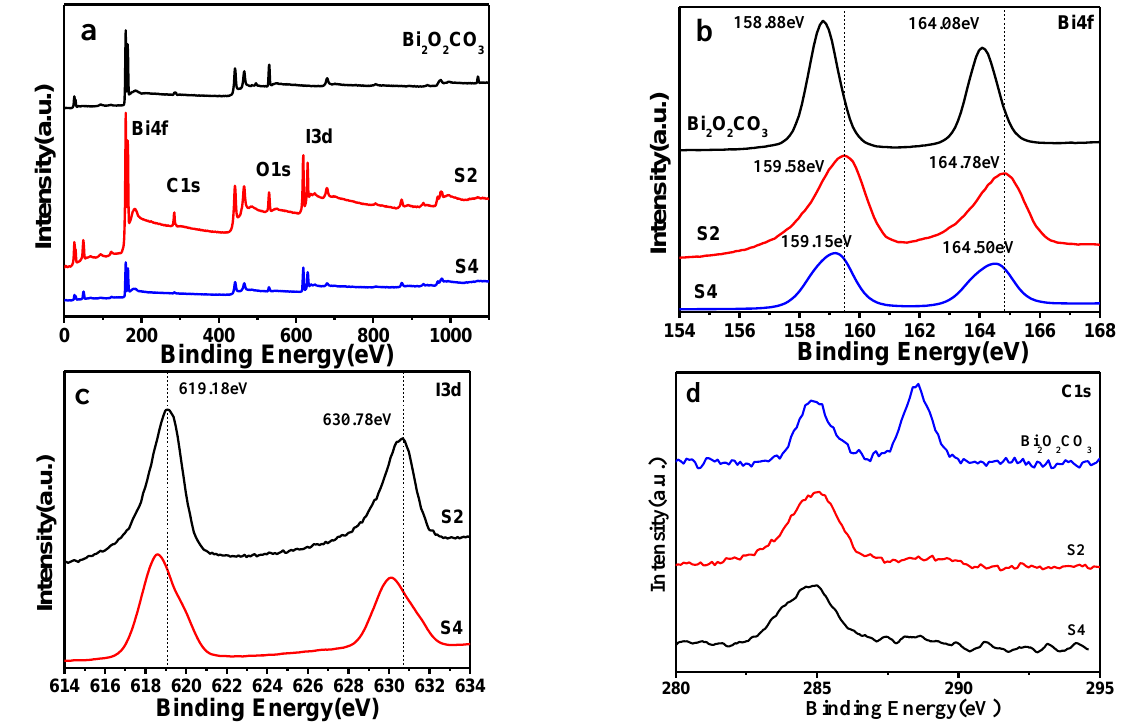
Figure 3. Survey ( a ) and high-resolution Bi 4f ( b ), I 3d( c ), and C 1s ( d ) XPS spectra of Bi 2 O 2 CO 3 , S2 and S4 samples. The FTIR spectra of Bi 2 O 2 CO 3 , S2 and S4 samples were measured, as shown in Figure 4. The intensive peak which centered at 847.1 cm − 1 is attributed to the ν 2 modes of the CO 32 − group. After Bi 2 O 2 CO 3 and BiOI are combined with each other, a new peak at 493.6 cm − 1 appears in S2 sample, further proving the formation of the strong interfacial junction between Bi 2 O 2 CO 3 and BiOI. Depending on the increase of the loaded content of BiOI, the main characteristic peak of the CO 32 − (847.1 cm − 1 ) almost disappears in the S4. This result is consistent with XRD and XPS results, verifying that the S4 sample is pure BiOI.